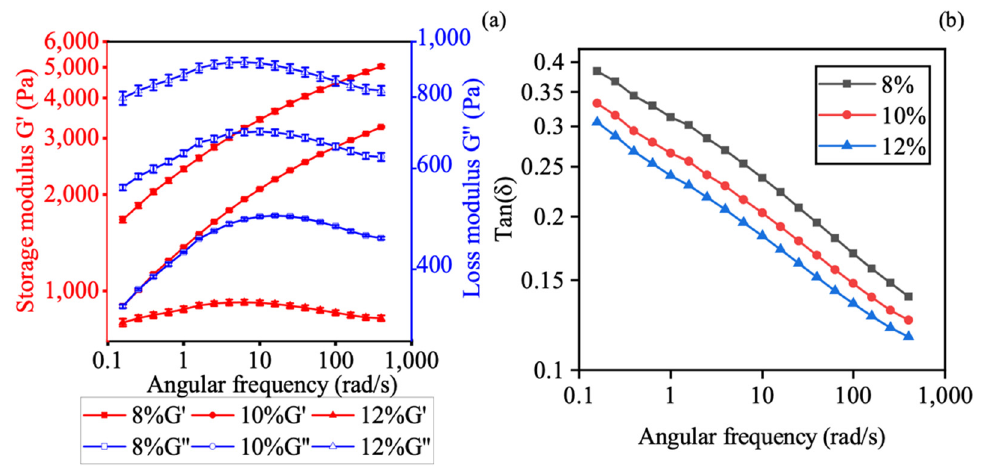
Figure 3. Oscillatory frequency sweep profile of CMC at different concentrations (8%, 10%, 12% w/w ): ( a ) storage modulus (G ′ ) and loss modulus (G ′′ ); and ( b ) tan δ . Values are presented as the mean ± SD ( n = 3).